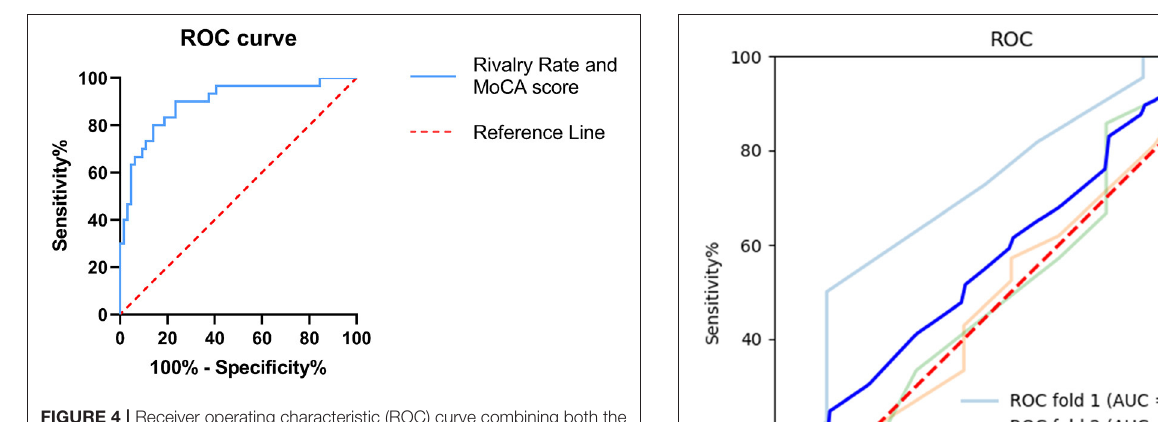
FIGURE 4 | Receiver operating characteristic (ROC) curve combining both the BR alternation rate and MoCA score. ROC analysis was used to assess the diagnostic efficiency. The area under the curve (AUC) was 0.894 (95% CI = 0.882–0.966). The ROC curve is shown in blue and the reference line in red.